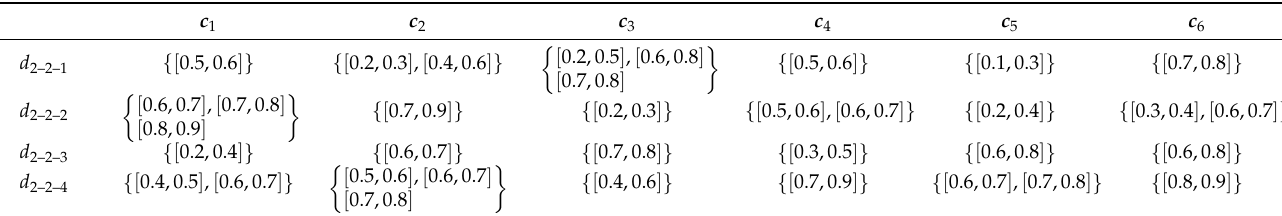
Table A14. Scoring matrix of objective health d 2–2 .